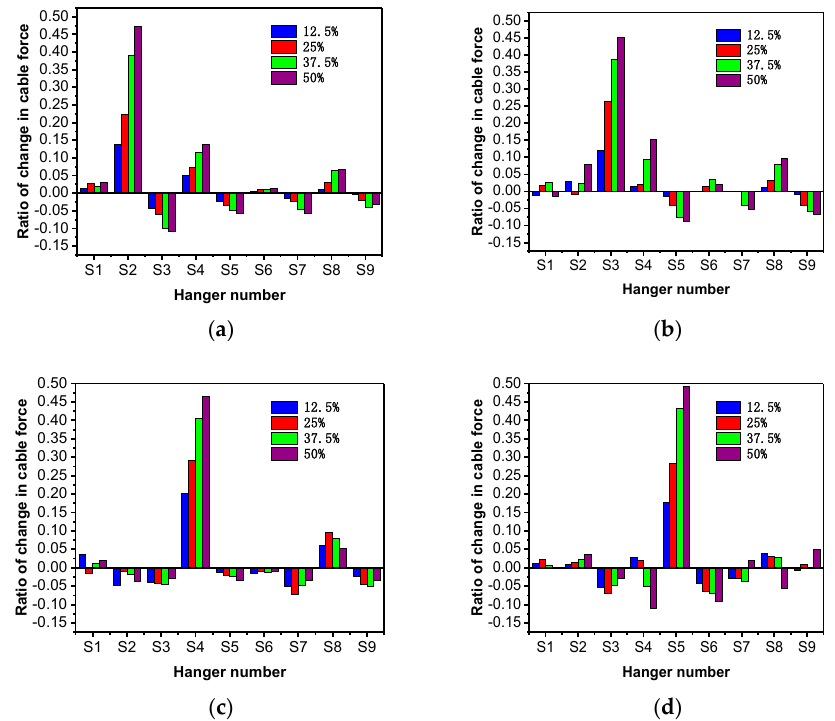
Figure 13. Damage identification results for EDC1–EDC16: ( a ) the preset damage hanger is S2; ( b ) the preset damage hanger is S3; ( c ) the preset damage hanger is S4; ( d ) the preset damage hanger is S5.